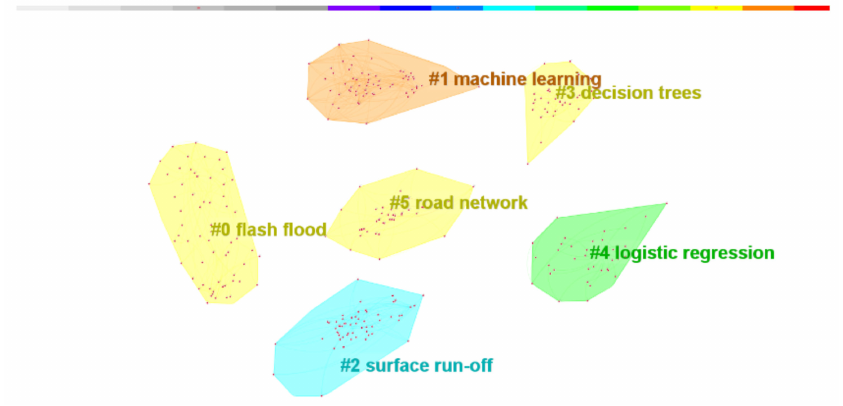
Figure 11. Author co-citation